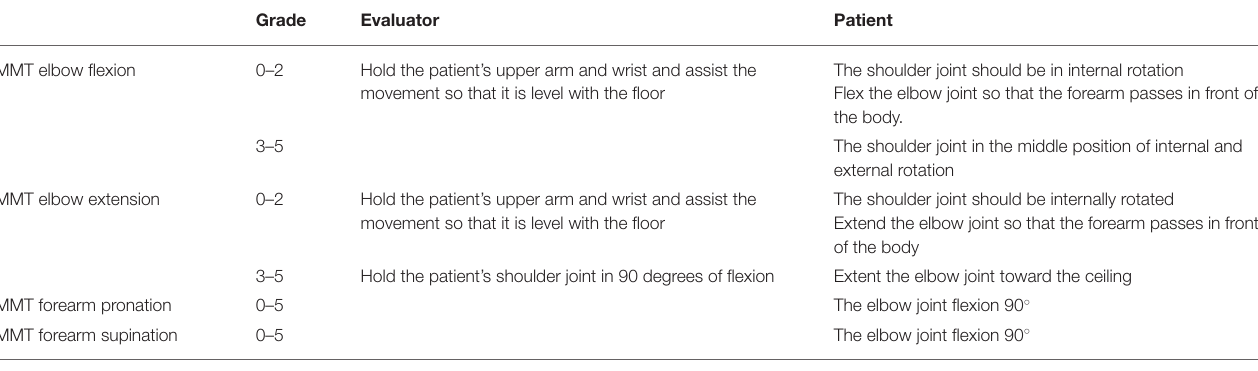
TABLE 1 | The method of MMT in the supine position.